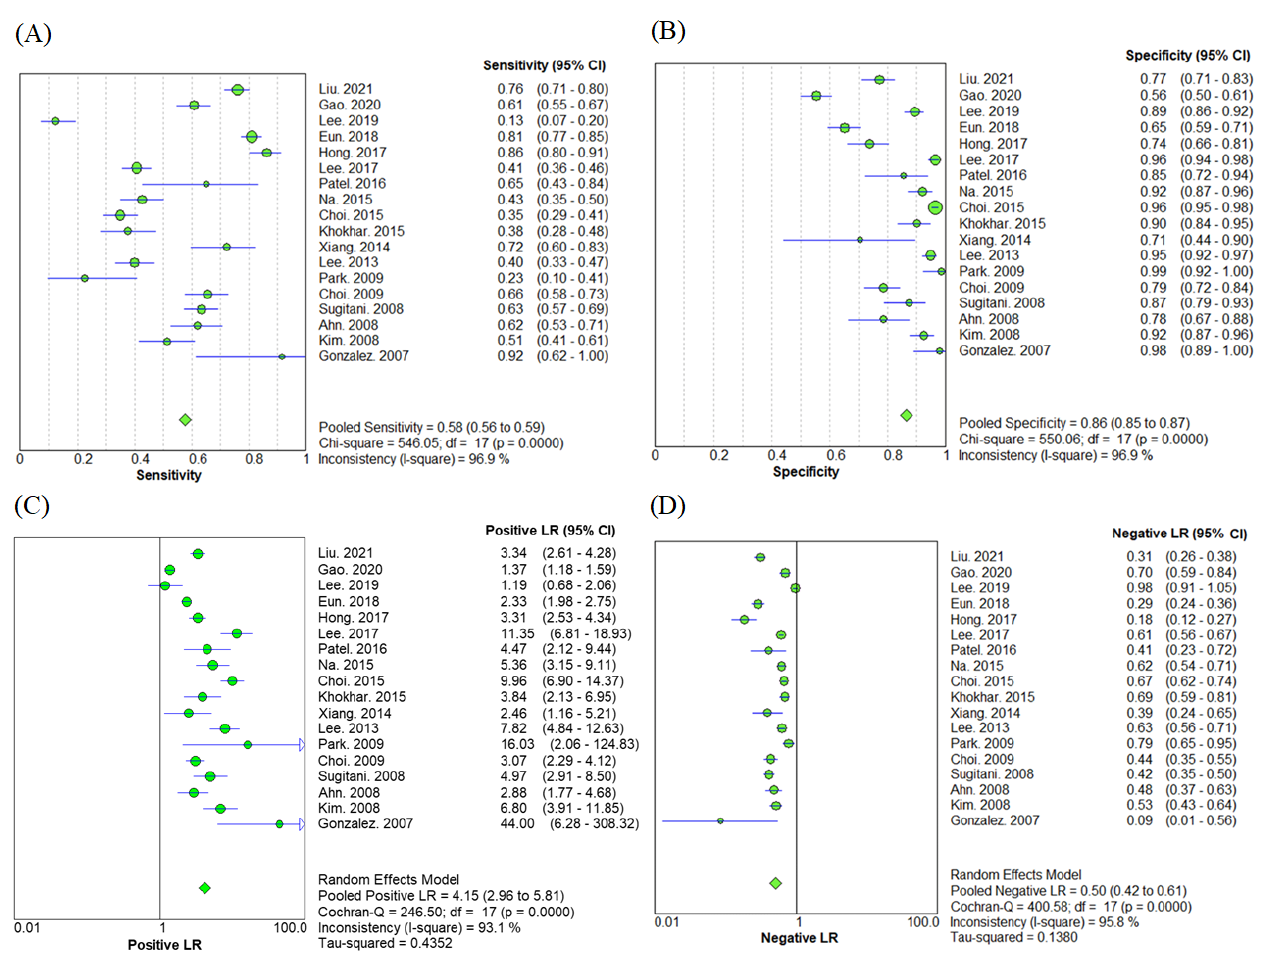
Figure 2. Diagnostic parameters of ultrasound performed by radiologists [18,20,22–30,32,34–39].